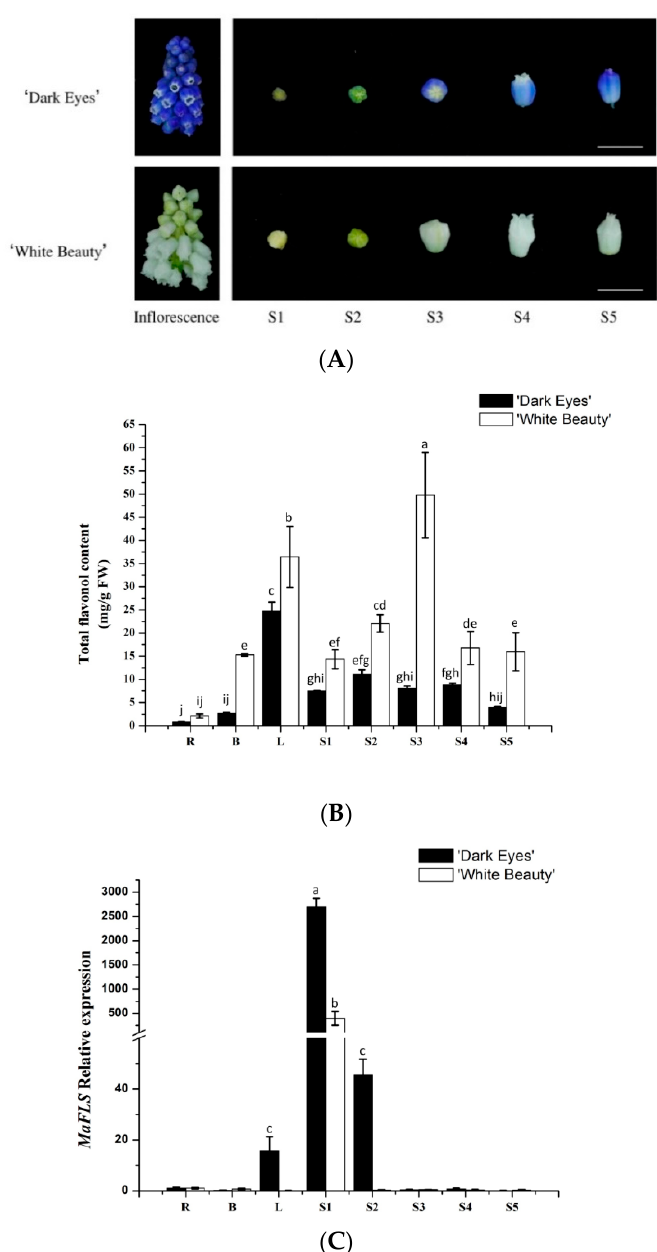
Figure 3. The flavonol content and expression profiles of MaFLS in M. aucheri “Dark eyes” and M. aucheri “White Beauty”. ( A ) The inflorescence and the petals at five flower developmental stages of M. aucheri “Dark eyes” and M. aucheri “White Beauty”. Bars, 5 mm. ( B ) The total flavonol content of petals. FW: Fresh weight. ( C ) The expression profile of MaFLS. Flavonol content and MaFLS expression were determined in roots (R), bulbs (B), leaves (L), and petals at five flower developmental stages (S1–S5). MaActin was used as the internal expression control. Each column represents means ± SD from three technical replicates. Different letters above the bars indicate significantly different values ( P < 0.05) calculated using one-way ANOVA followed by a Duncan’s multiple range test.